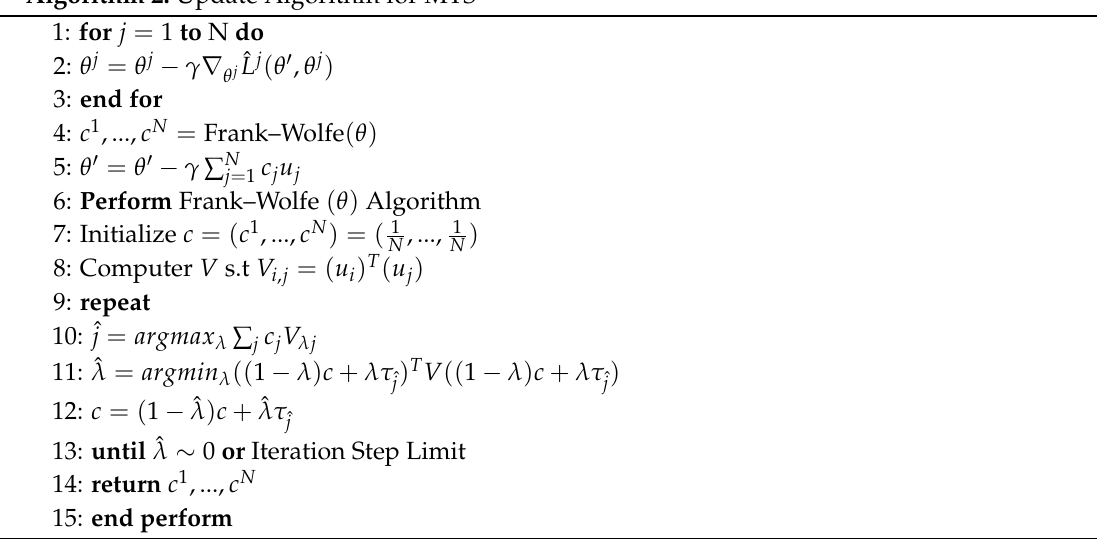
Algorithm 2: Update Algorithm for